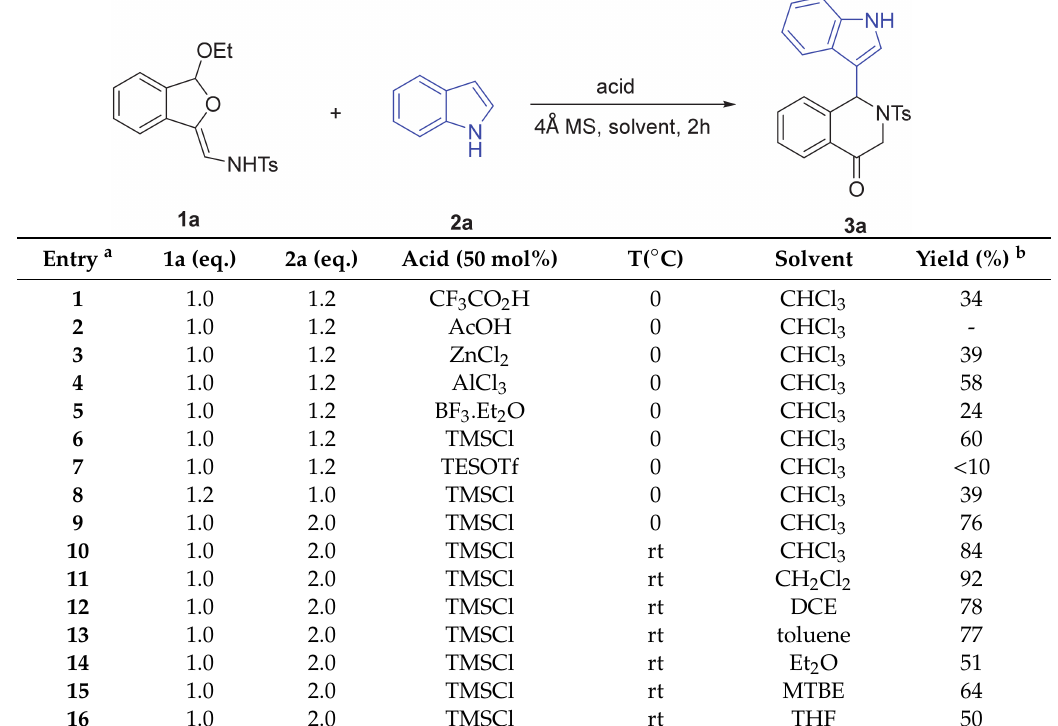
Table 1. Optimization of the Reaction for the Synthesis of Indole-substituted